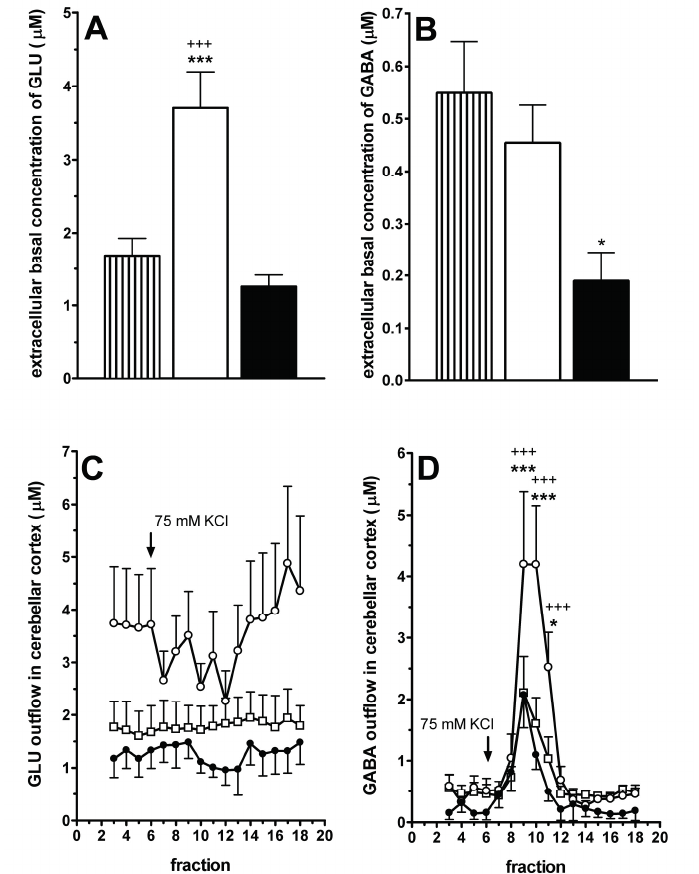
Figure 6. Liver growth factor modulates glutamate and GABA concentration in the cerebellar cortex of 3-acetylpyridine-lesioned rats. Panels A and B show the extracellular basal concentration of glutamate and GABA in the cerebellar cortex of naïve rats (lined bars), and 3-AP-lesioned rats treated with vehicle (white bars) or LGF (black bars). Note how LGF treatment prevents the increase in the extracellular glutamate basal concentration promoted by 3-AP ( A ), and how the factor also reduces the basal concentration of GABA ( B ); Panels C and D show the release of glutamate ( C ) and GABA ( D ) in the cerebellar cortex after stimulation with 75 mM KCl. Note how 3-AP increases the release of GABA ( D , white circles) in comparison with naïve ( D , white squares) and 3-AP + LGF treated rats ( D , black circles). Results represent the mean ± SEM of 4 to 8 individual animals. * p ≤ 0.05, *** p ≤ 0.001 vs. naïve rats, +++ p ≤ 0.001 vs. 3-AP + vehicle